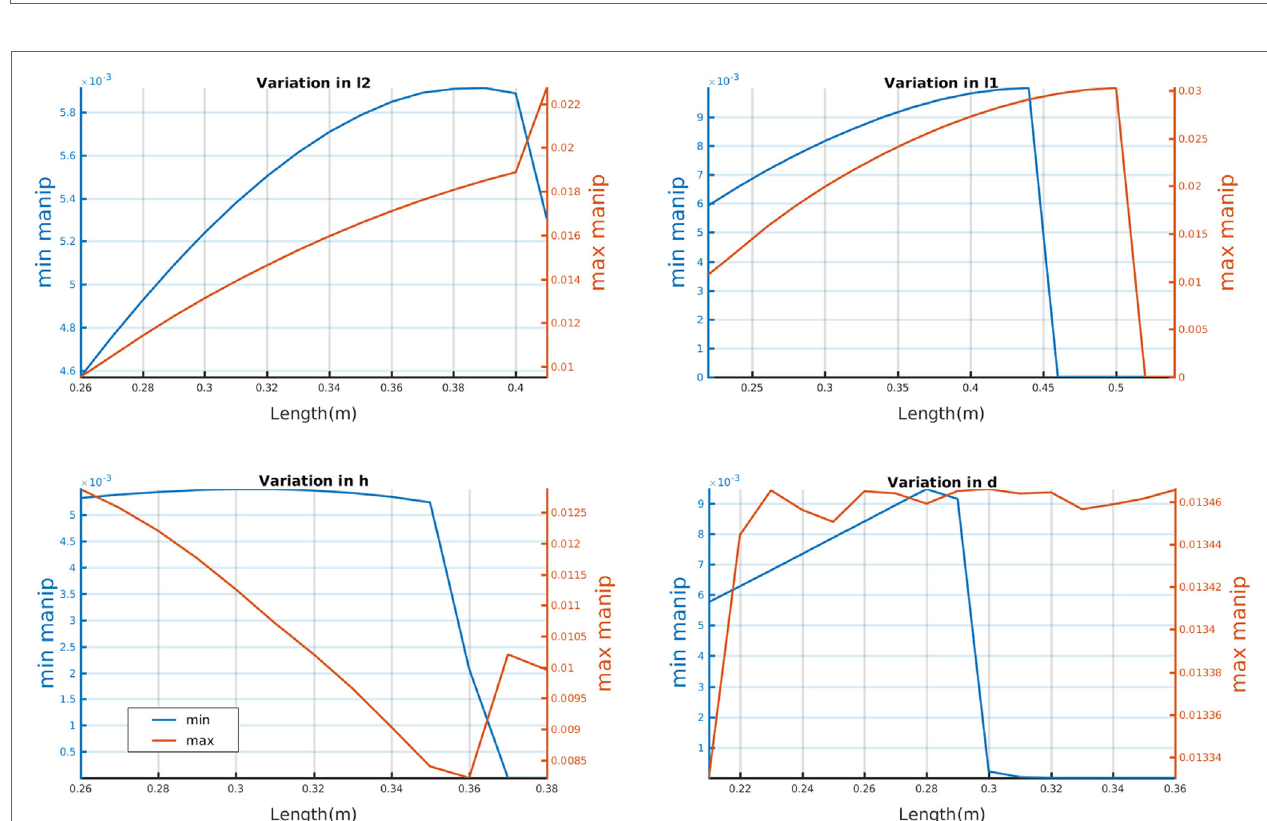
FigUre 7 | The plot shows one of the participants performing the drawing task. The tracked path, the force variation along the task, and the stiffness variation along the task trajectory are shown in the